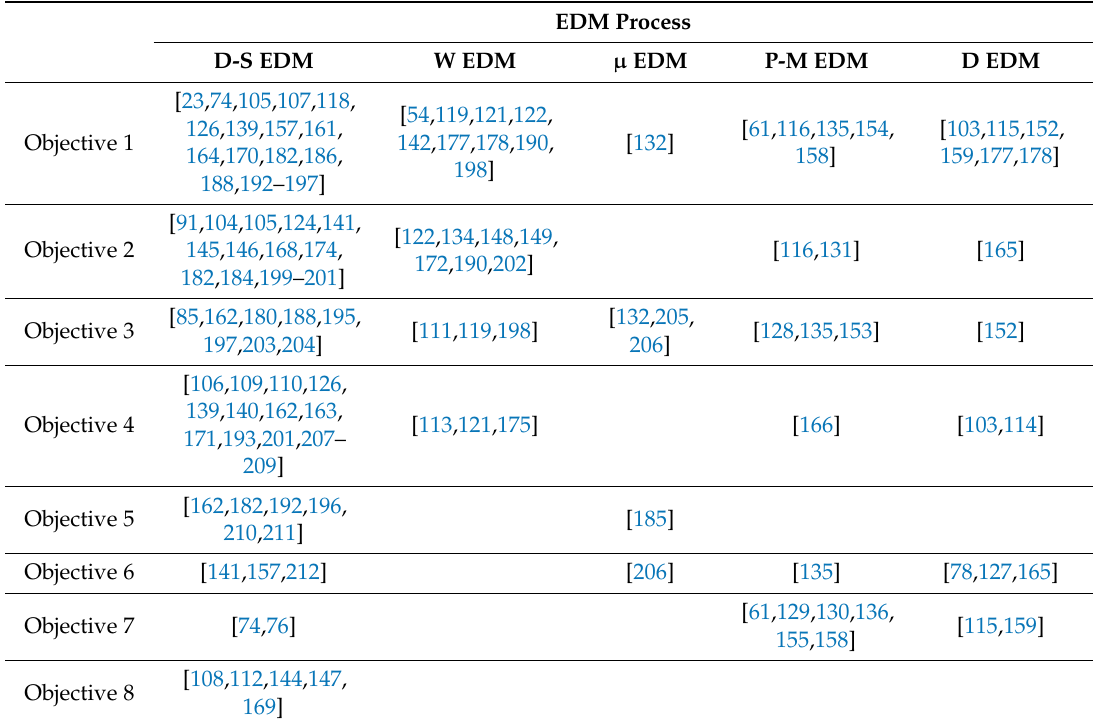
Table 2. Studies for di ff erent grades of tool steel machined using various EDM processes. D-S—die sinking; W—wire; µ —micro; P-M—powder-mixed;